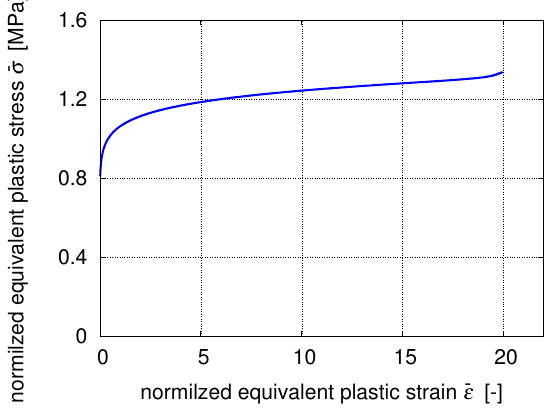
Figure 4. Normalized equivalent plastic strains in regions A and B (strain normalized with respect to the mean uniform strain).